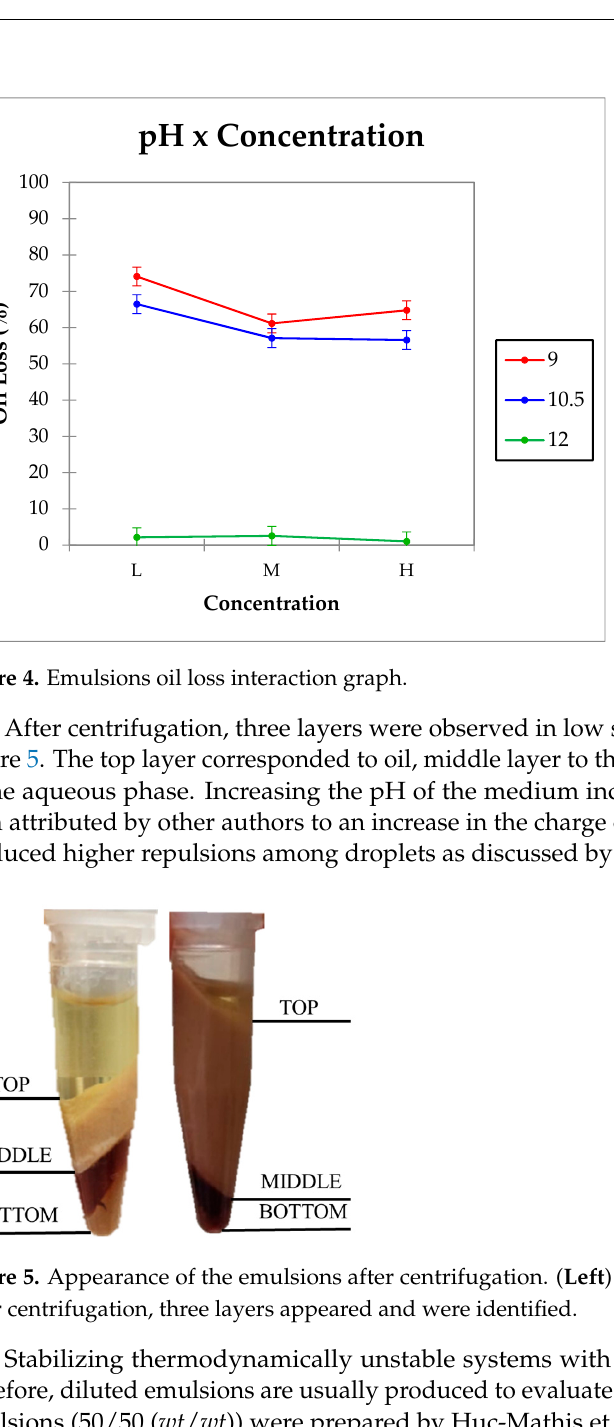
Figure 5. Appearance of the emulsions after centrifugation. ( Left ) sample 9H; ( right ) sample 12H. After centrifugation, three layers appeared and were identified.